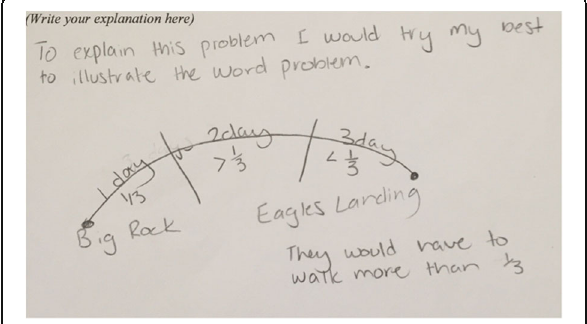
Fig. 1 Student response that illustrated the relationship between values in the problem. Note: The student ’ s misunderstanding of the “ less than ” and “ greater than ” signs is irrelevant to the